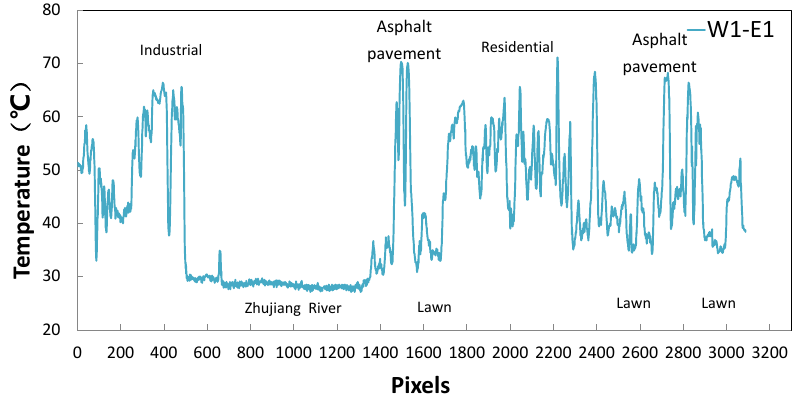
Figure 11. LST on profile W1-E1 (Lines marked in Figure